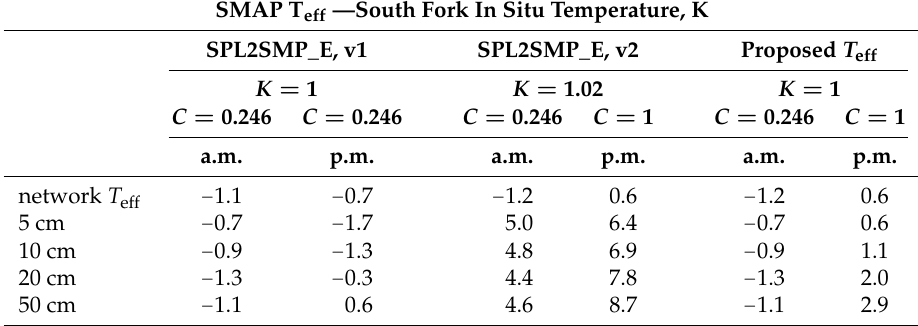
Figure 4. Soil depths observed by the permanent edge-of-field stations in the South Fork compared with GEOS-5 soil layers used for T SL1 and T SL2 in the calculation of SMAP T eff . Table 4. Difference between SMAP T eff and South Fork soil temperature for April 2015–November 2017 (excluding